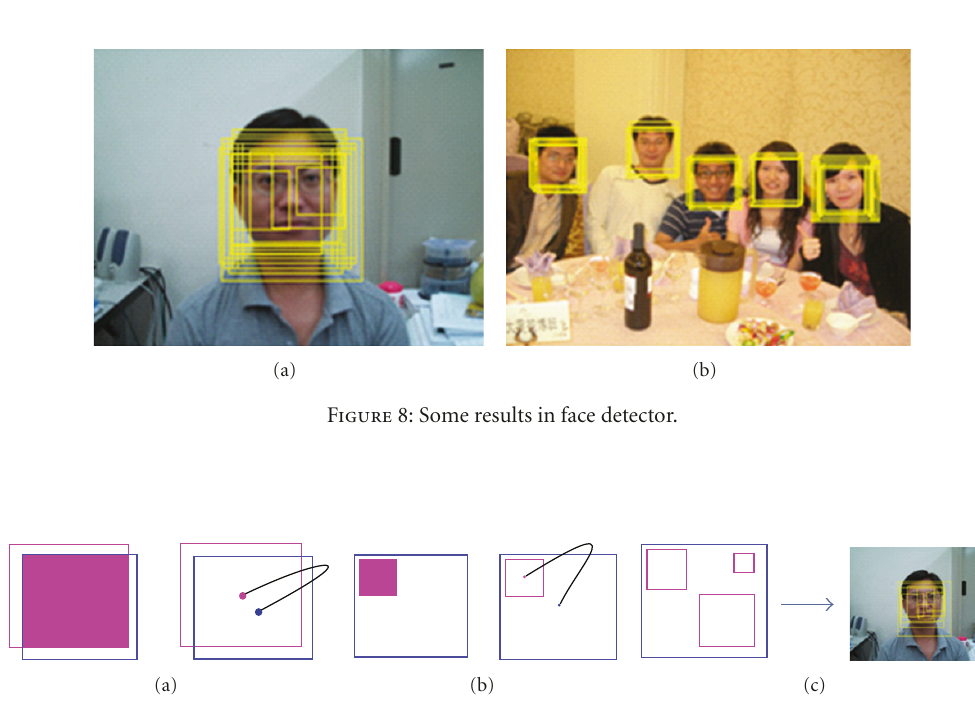
Figure 9: Examples of overlapped regions and the distance of centers of two blocks, (a) the same cluster, (b) two di ff erent clusters, (c) a special case, more than two blocks overlapping.